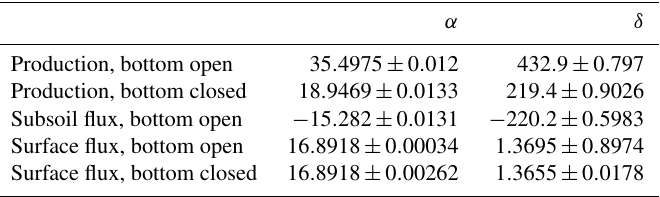
Table 4. Coefficients for the calculation of denitrification rates using Eq. (1) based on chamber concentrations for 2h chamber closing time, 30cm depth of 15 N labelling, chamber height of 15, 15cm diameter and assuming subsoil diffusivity identical to diffusivity of the 15 N-labelled soil. Coefficients α and δ were derived by regression analysis of modelled concentration ( R 2 > 0 . 999).